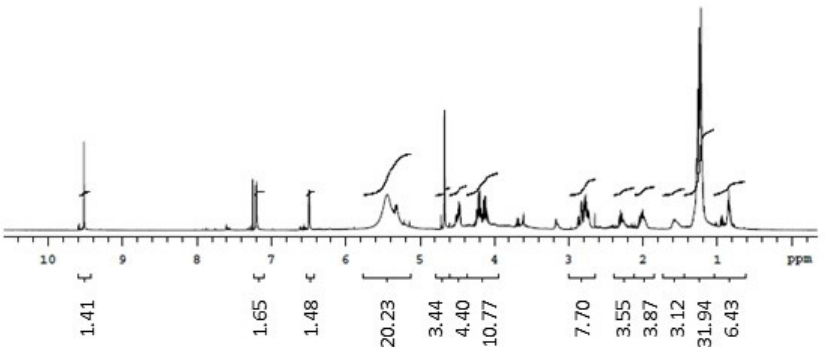
Figure 8. 1 H NMR spectrum (CDCl 3 , 300 MHz) of the biosurfactant from Malpighia emarginata.